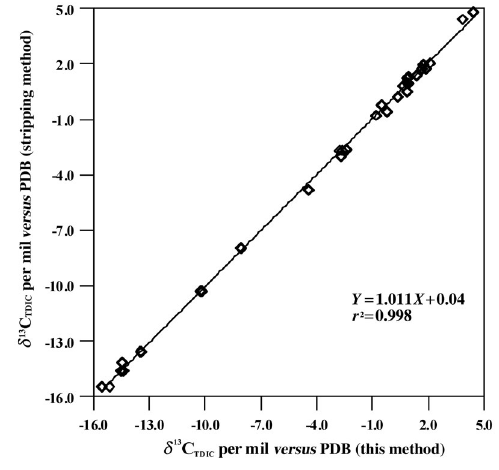
Fig. 5. Comparison between the δ 13 C TDIC values obtained using the proposed method and those car- ried out following the chemical and physical strip- ping technique (Favara et al. , 2002) for some natural water samples The least-squares regression line for all the data set ( Y = 1.011 X + 0.04, r 2 = 0.998) high- lights comparable results over the whole range of isotope